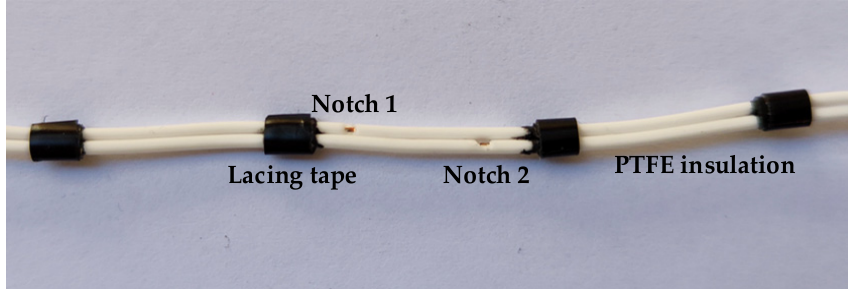
Figure 2. Polytetrafluoroethylene (PTFE)-insulated wire electrodes used to test the different sensors. The width of the notches is 1 mm and the distance between notches is 10 mm.